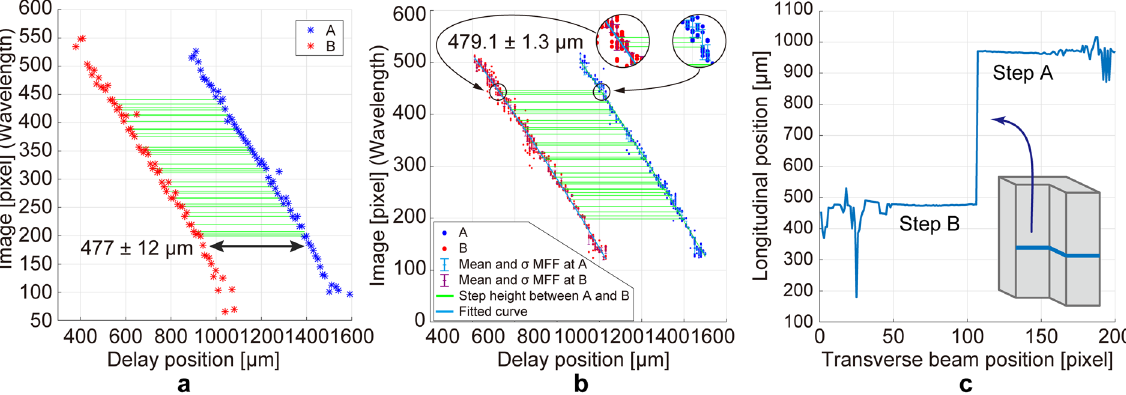
Figure 5. Results of the step measurement. ( a ) Series of MFFs corresponding to the central areas of steps A and B. ( b ) Series of MFFs for all 36 beam positions obtained by changing delay positions. Detailed explanations can be found in the text. ( c ) Profile for the step shape of gauge blocks obtained from one-shot imaging at a delay position of 960 µ m (Fig. 4c). Overlapping regions between the areas A and B due to the diffraction of the edge are not shown and the edge position was determined based on the rough estimation of the irradiated beam